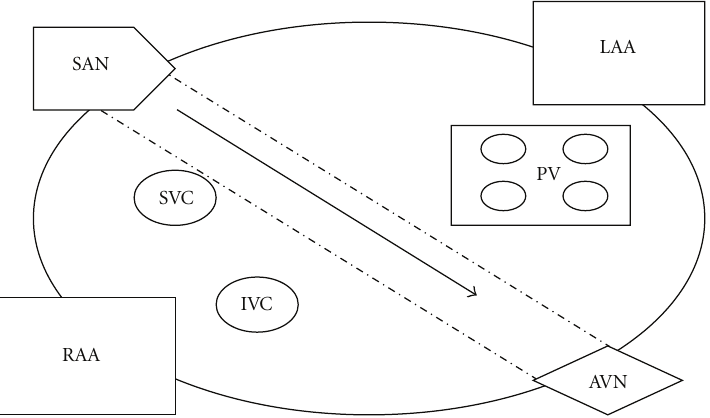
Figure 1: The Corridor Procedure designed by Guiraudon in 1985. Arrow show the direction of flow of electrical current. (SN: SA node, PV: pulmonary veins, AVN: atriventricular node, SVC: superior vena cava, IVC: inferior vena cava, LAA: left atrial appendage, and RAA: right atrial appendage).